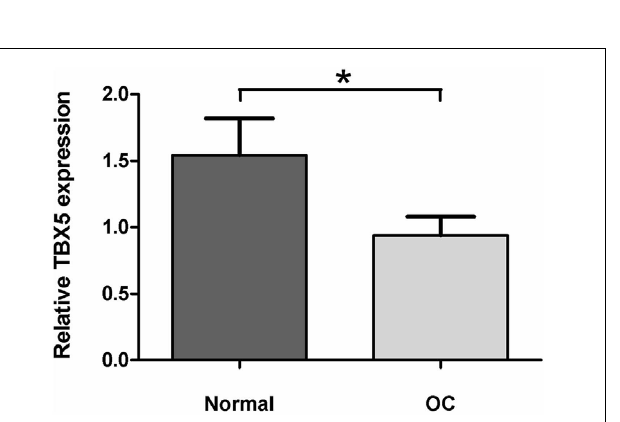
FIGUREA5 |TBX5 expression in normal and osteochondrosis (OC) lesion of articular cartilage tissues ( n = 8) . RelativeTBX5 expression was determined by the 2 − ∆∆ method (Livak and Schmittgen, 2001). Data represents mean ± SEM. * p <